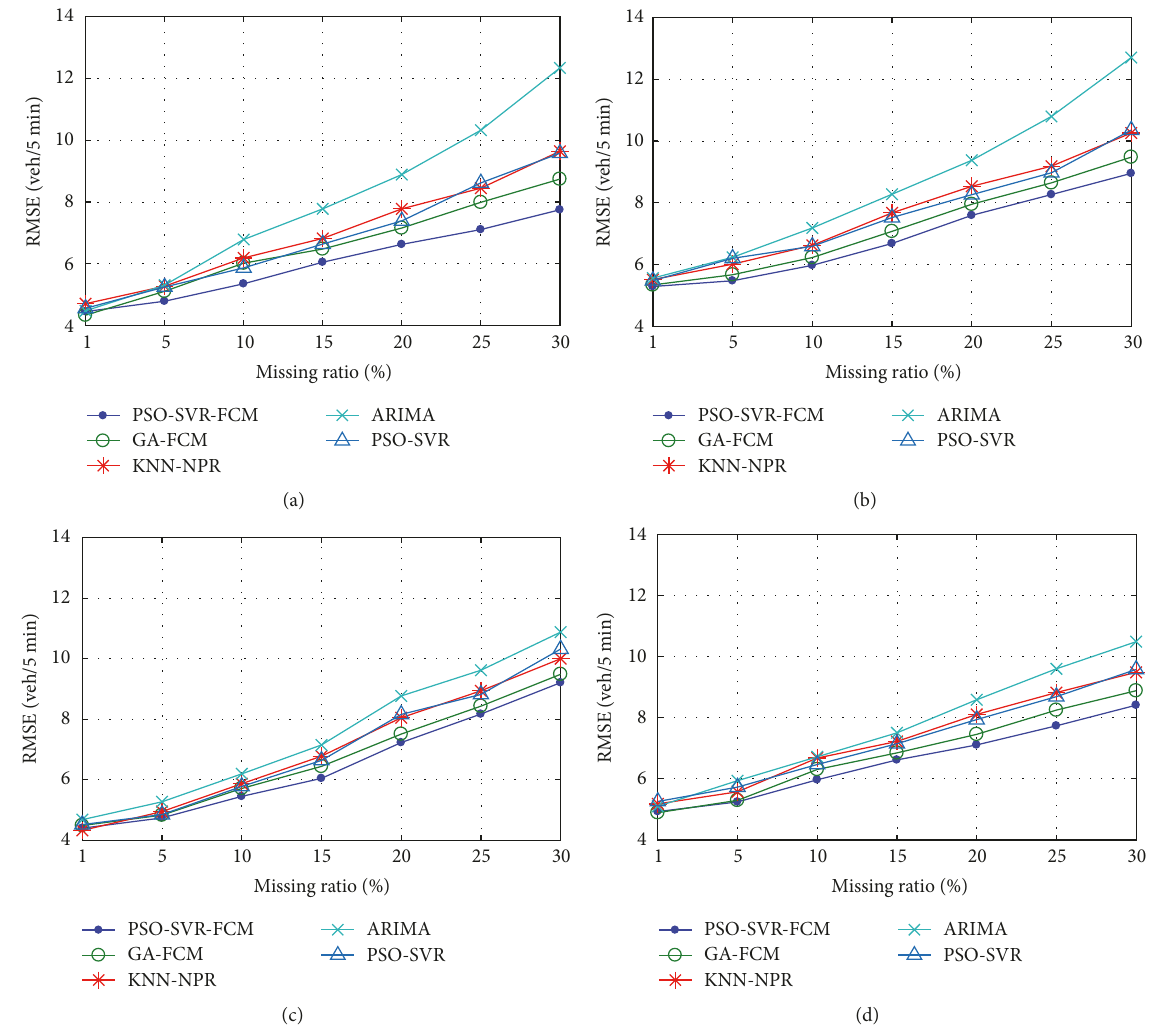
Figure 16: RMSE curve of each method for comparison in mixed MCR/MR pattern, using the traffic data collected from the detectors (a) NBXX13 (2) , (b) NBXX11 (4) , (c) DC00004964(E2), and (d)